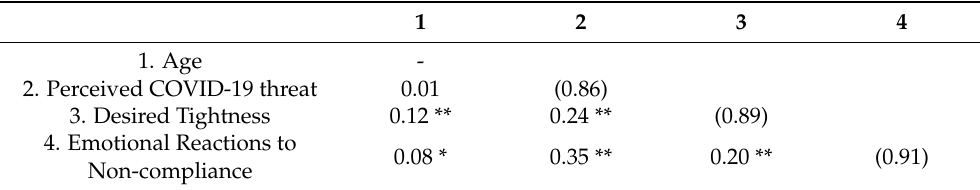
Table 3. Bivariate Correlations.